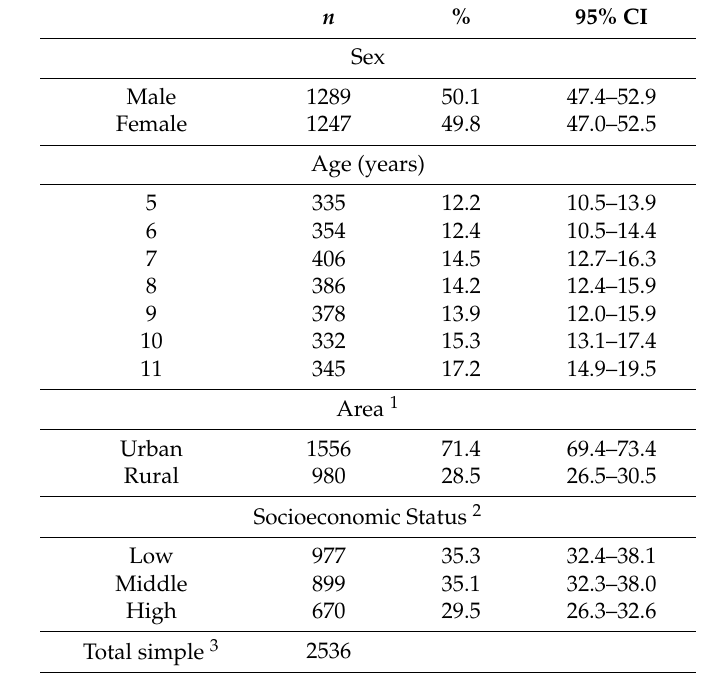
Table 2. Socio-demographic characteristics of Mexican school-age children (five to eleven years old). National Survey of Health and Nutrition 2012, Mexico.